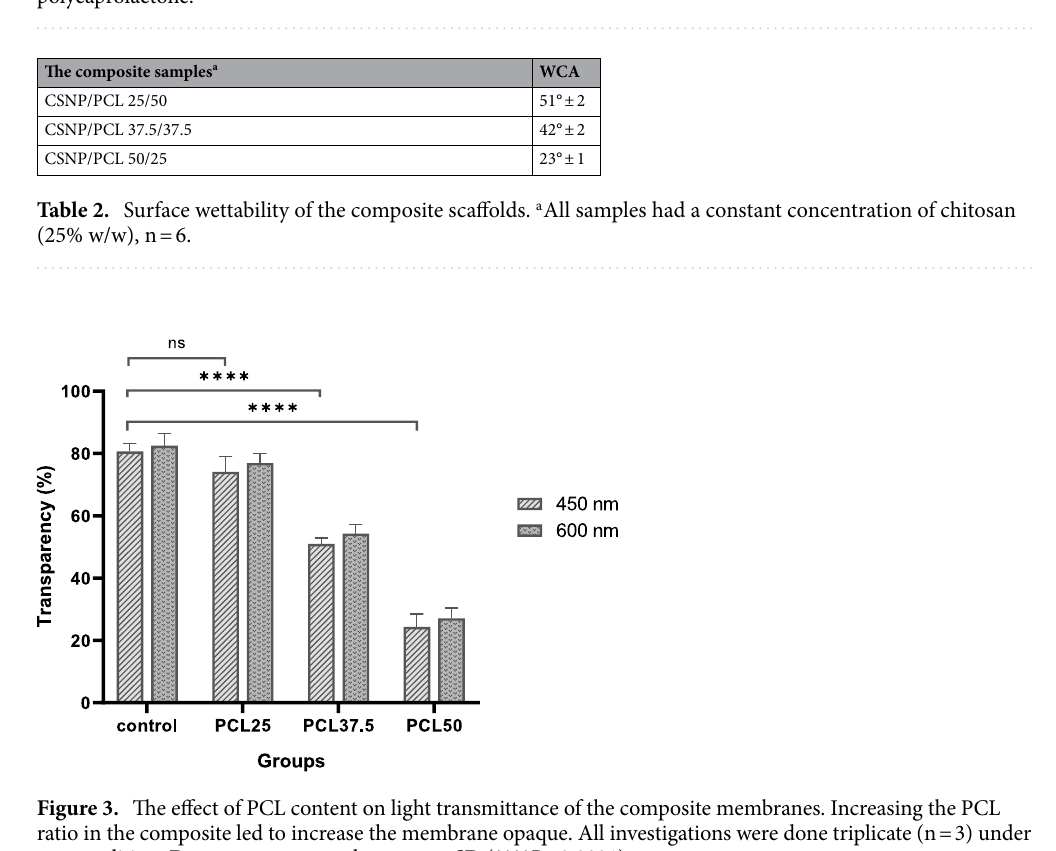
Figure 2. Macroscopic photographs of: ( a ) Dried composite membranes, visual transparency of the membrane decreased by increasing the PCL content. ( b ) CSNP/PCL 50/25 membranes became much more transparent and flexible by immersing in PBS compared with dried membranes. CSNP: chitosan nanoparticle, PCL: polycaprolactone.